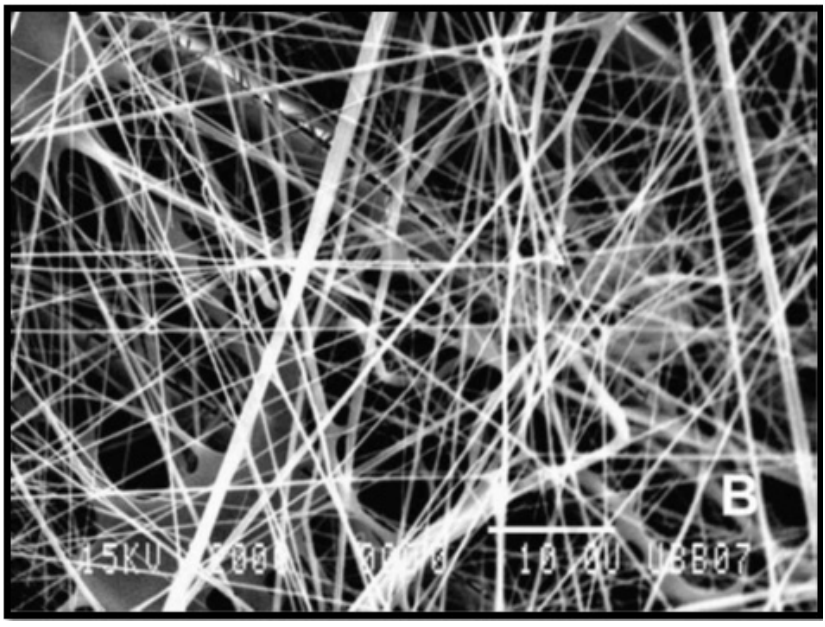
Figure 3. Scanning electron microscopy (SEM) micrograph (2000×) of poly (L-lactic) acid (PLLA) fibres produced from electrospinning [45] .